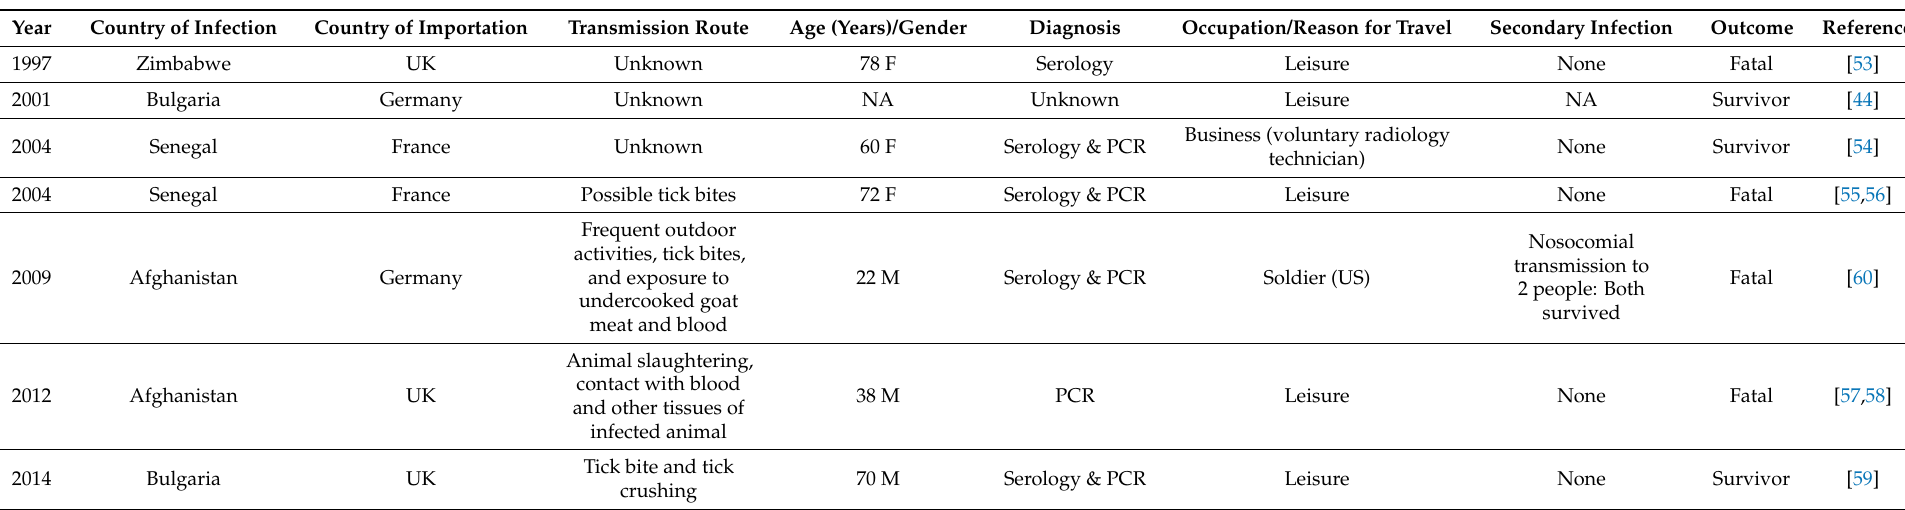
Table 2. Travel-associated Crimean-Congo hemorrhagic fever (CCHF) cases in western